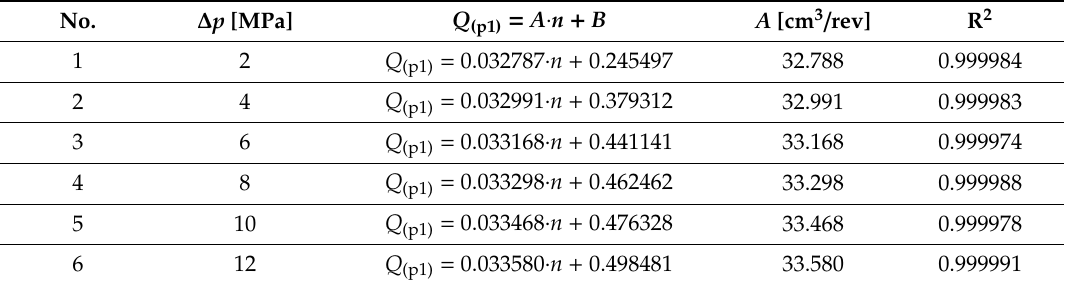
Table A4. Equations Q (p1) = A · n + B of motor output flow rate at ∆ p = const. (Toet’s